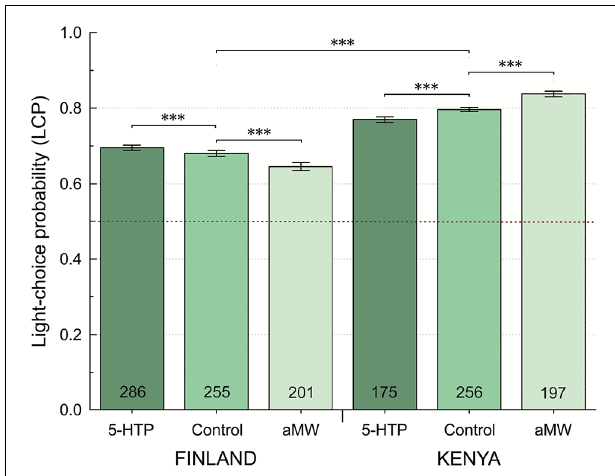
FIGURE 1 | Light-choice probability (LCP) by site and pharmacological treatment. 5-HTP, Tryptophan, a precursor of serotonin synthesis; α MW,